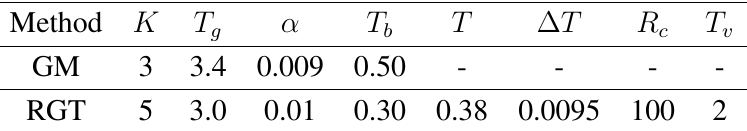
Table 2. Parameters for the experiment using our dataset.